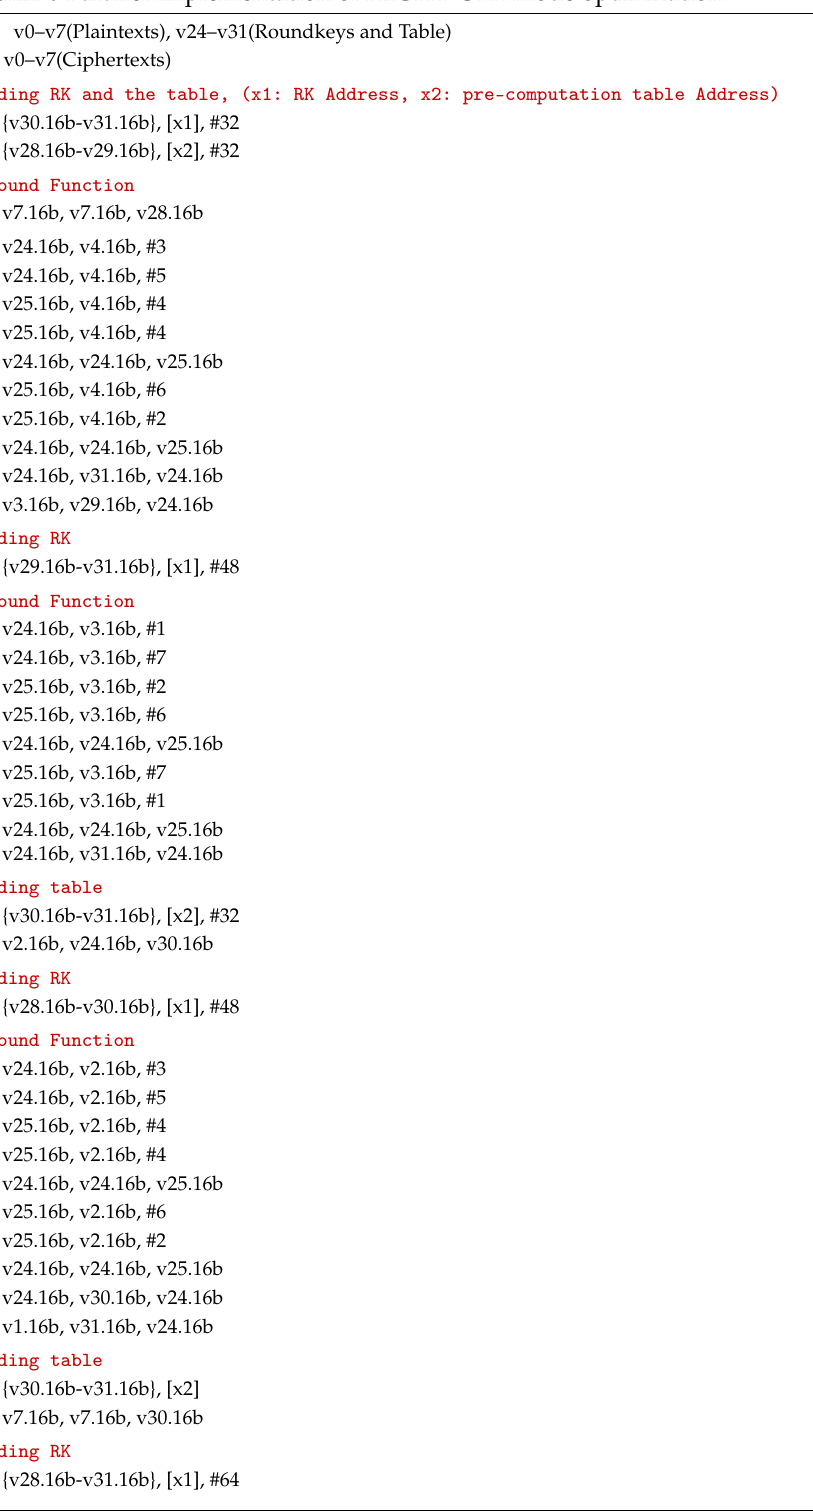
Algorithm 6 Parallel implementation of HIGHT-CTR mode